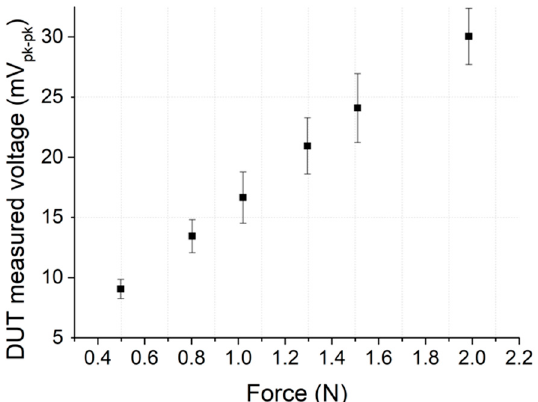
Figure 2. The average response of the ferroelectret sensor over the range of frequencies of interest (10 Hz to 80 Hz) for different applied forces (error bars: standard deviations over frequencies).